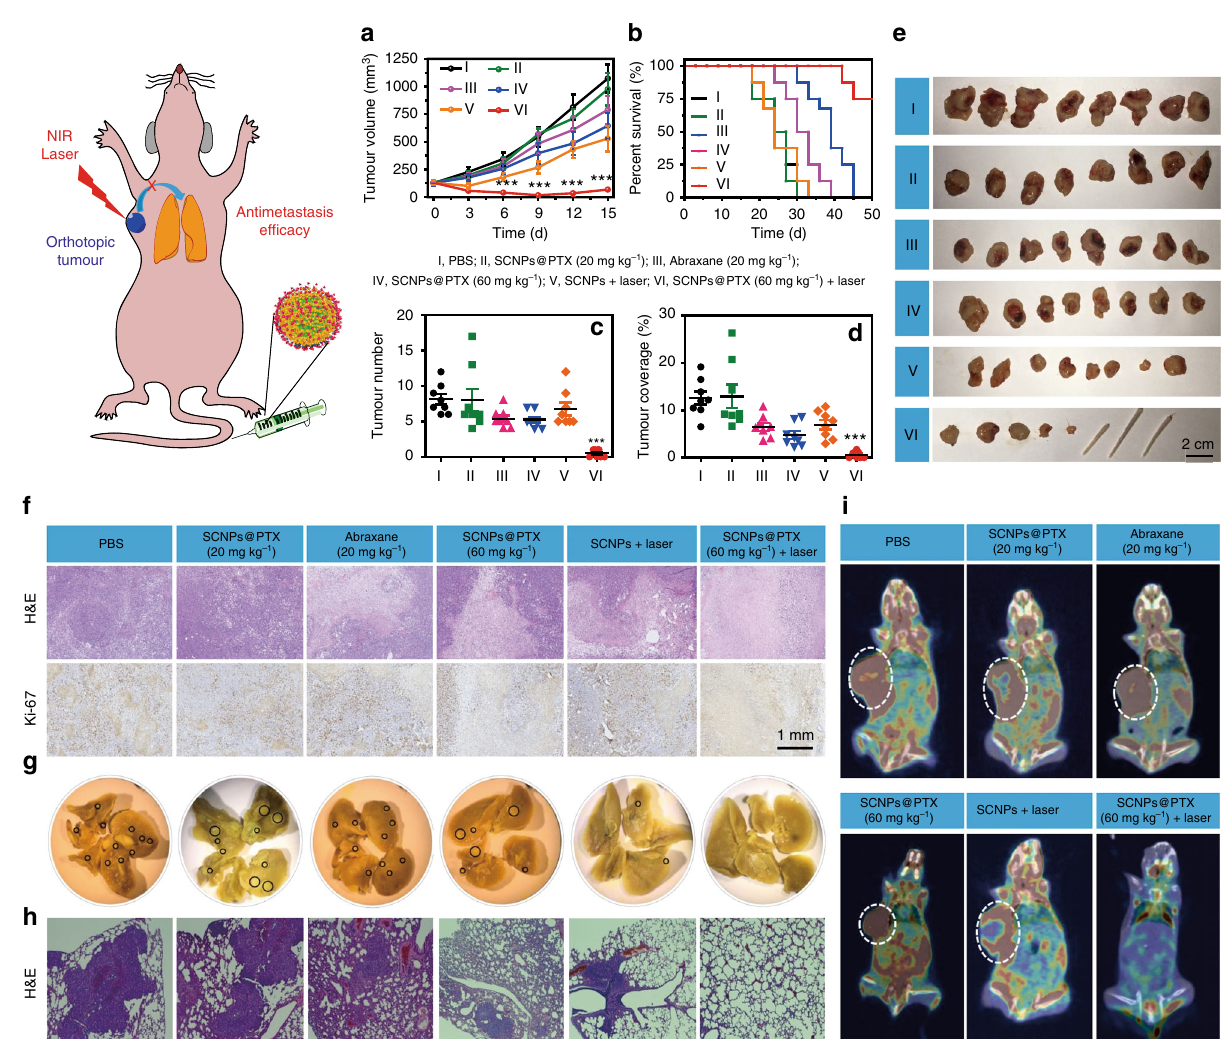
Fig. 8 Treatment of orthotopic breast cancer and inhibitory effects on lung metastasis. a Tumour volume changes and b Kaplan – Meier survival curves of the mice bearing orthotopic 4T1 breast tumours treated with different formulations after one injection ( n = 8). c The numbers of tumour nodules present on the lung surface from each group. d Tumour coverage percentage in the lungs from each group. e Photo images of the orthotopic tumours harvested from the mice treated with different formulations. f H&E and Ki-67 staining of the tumour tissues from each group. g Representative images of the lungs excised from each group. The black circles denote the visually detected metastatic nodules in each lung tissue. h Histological examination of metastatic lesions in lung tissues from each group after H&E staining. i PET/CT images of the mice treated with different formulations at the 14th day post-injection. Arrows indicates possible metastatic tumours. The laser density was 0.5 W cm − 2 , and the irradiation time was 5 min. Data are expressed as means ± s.e. m., *** P <